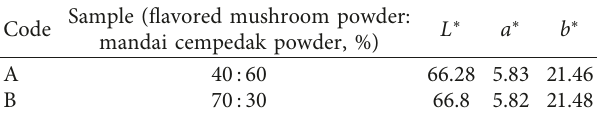
Table 7: Results of color